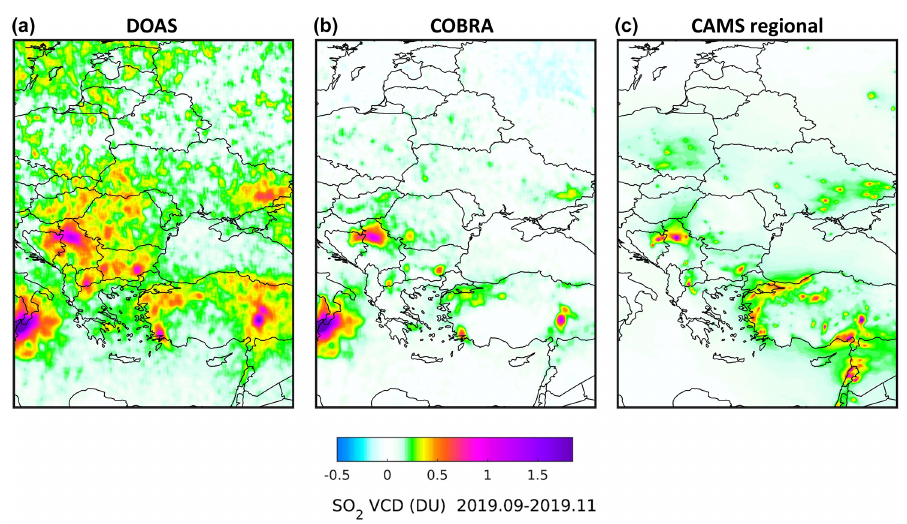
Figure 4. Seasonal mean SO 2 columns for September to November 2019 from (a, b) TROPOMI DOAS and COBRA retrievals, and (c) simulated by the CAMS regional model. The CAMS data are displayed at the 0.1 ◦ × 0.1 ◦ native